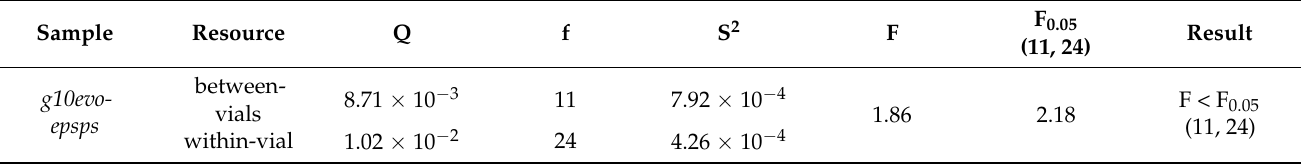
Table 3. Results of the homogeneity